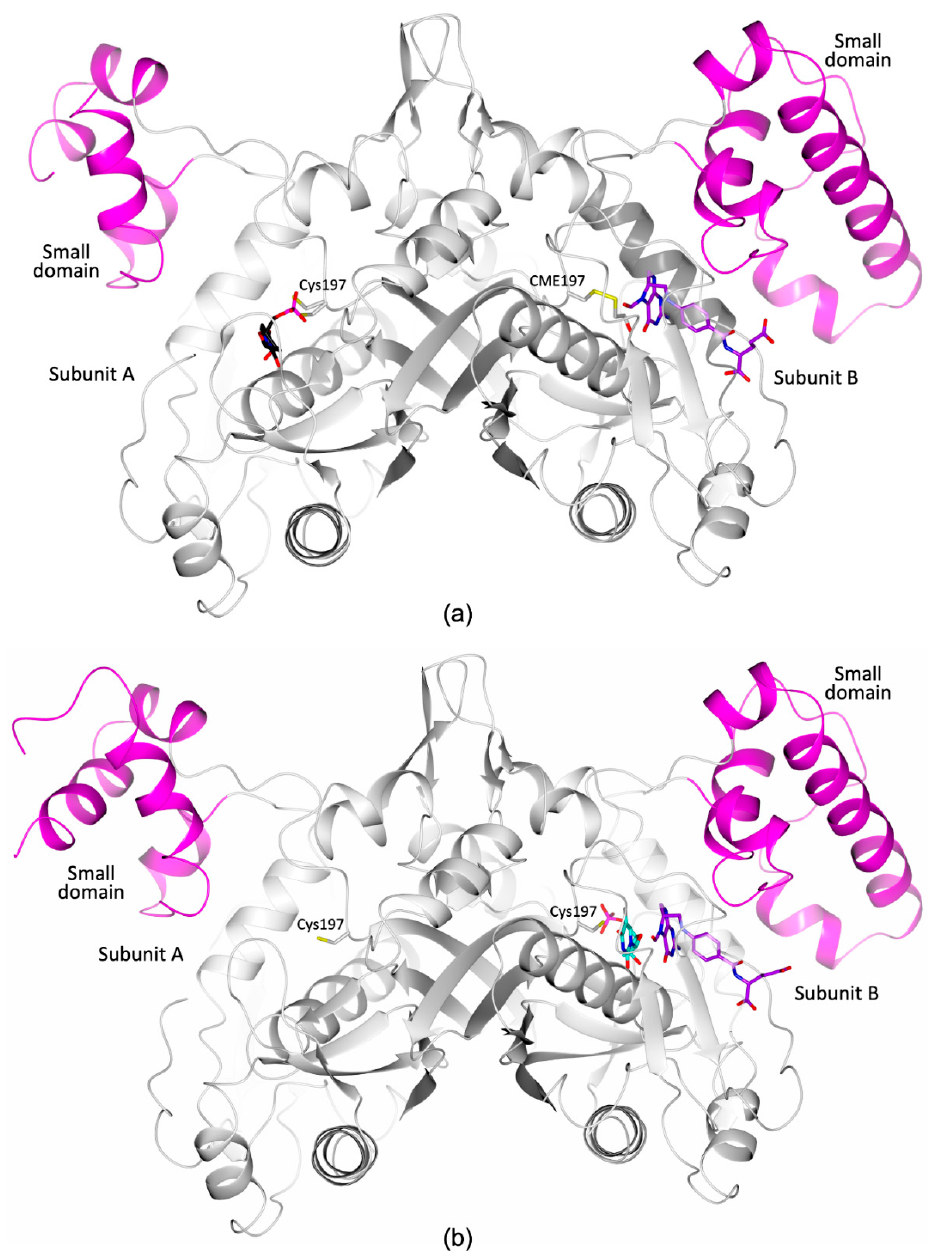
Figure 2. Dimer of Ef TS (large and small domains are represented as grey and dark pink cartoon, respectively) in complex with ( a ) dUMP (in sticks, black carbons) and ( b ) FdUMP (in sticks, cyan carbons). Structural heterogeneity within the functional Ef TS dimer is observed in both complexes. In the Ef TS–dUMP complex, the nucleotide is bound to subunit A, whereas the cofactor-like molecule 5-formyl-6-tetrahydrofolate (5-FTHF, in sticks, purple carbons) occupies the active site of subunit B in which the catalytic cysteine is modified as S , S -(2-hydroxyethyl)thiocysteine (CME197, in sticks, grey carbons). On the other hand, in the Ef TS–FdUMP complex, the substrate-like inhibitor (in sticks, cyan carbons) is bound to subunit B together with the cofactor-like molecule 5-FTHF (in sticks, purple carbons).